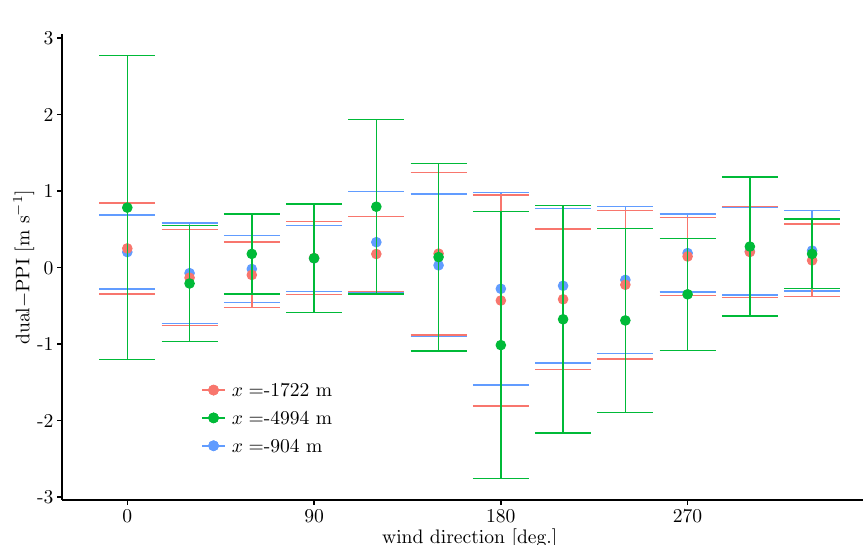
Figure 11. The mean (marker) standard deviation (error bars) of the difference between 10 min mean ± reconstructed wind speeds from the dual and PPI setups at 50 m ASL at three different westward positions. The x -position is relative to Vara (pos. 2) with positive values going